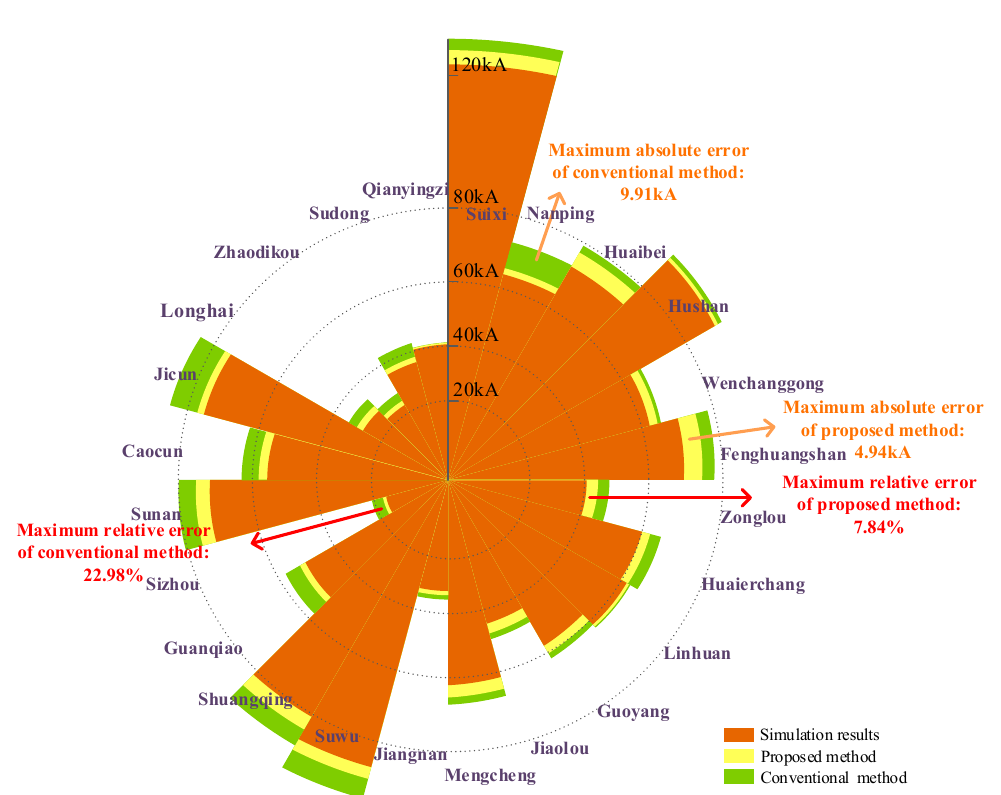
Figure 18. The peak value of short-circuit current of substations.